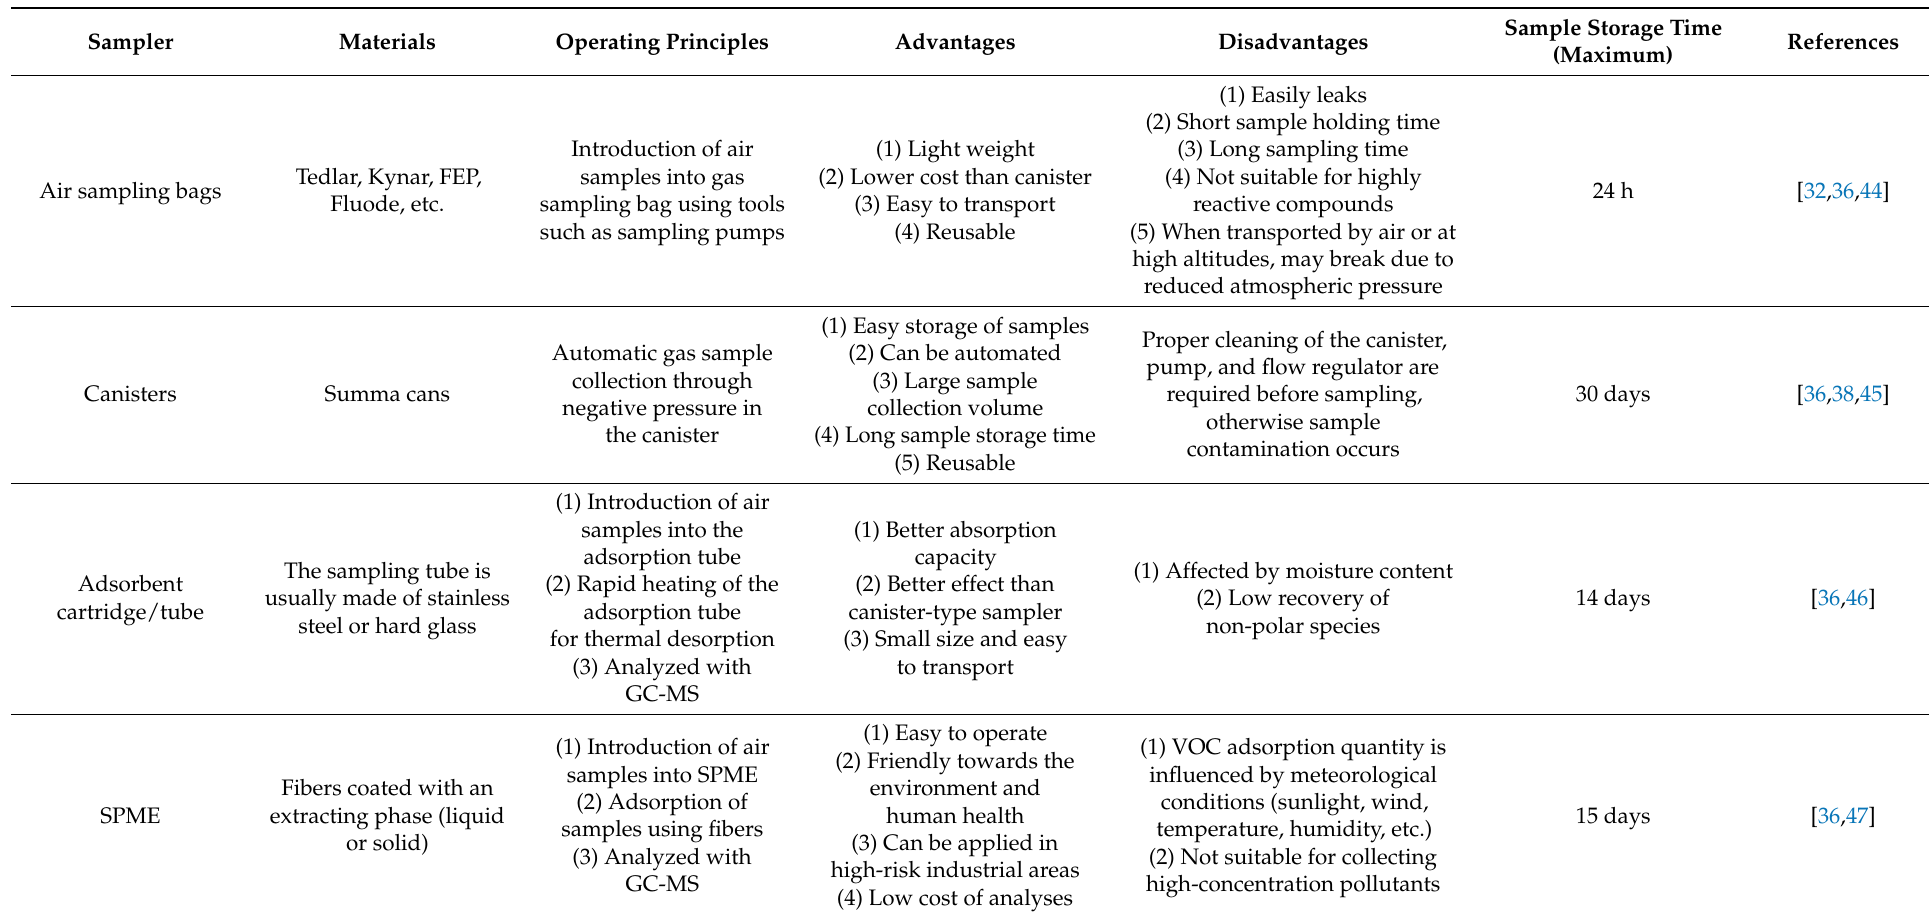
Table 1. Primary information about VOC air